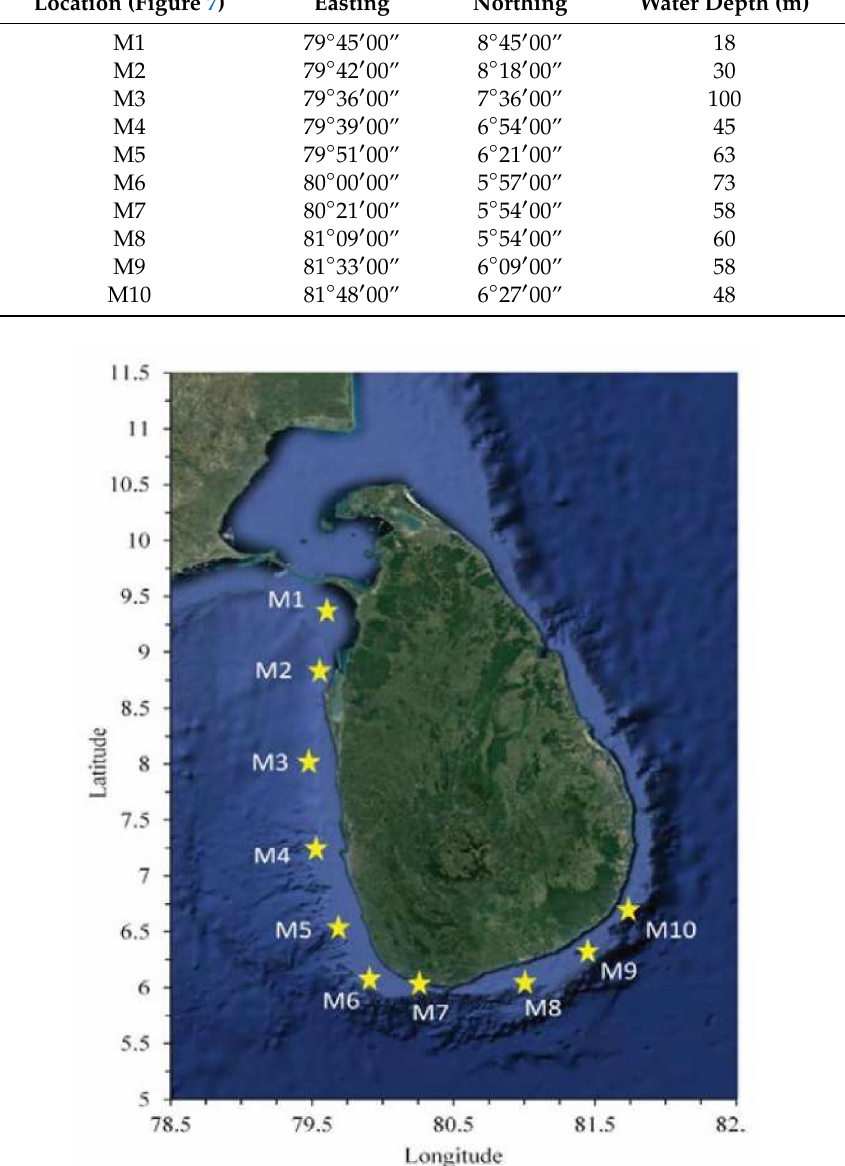
Figure 7. O ff shore locations around the west and south coast, used to investigate the impact of global climate change on wave energy resource of Sri